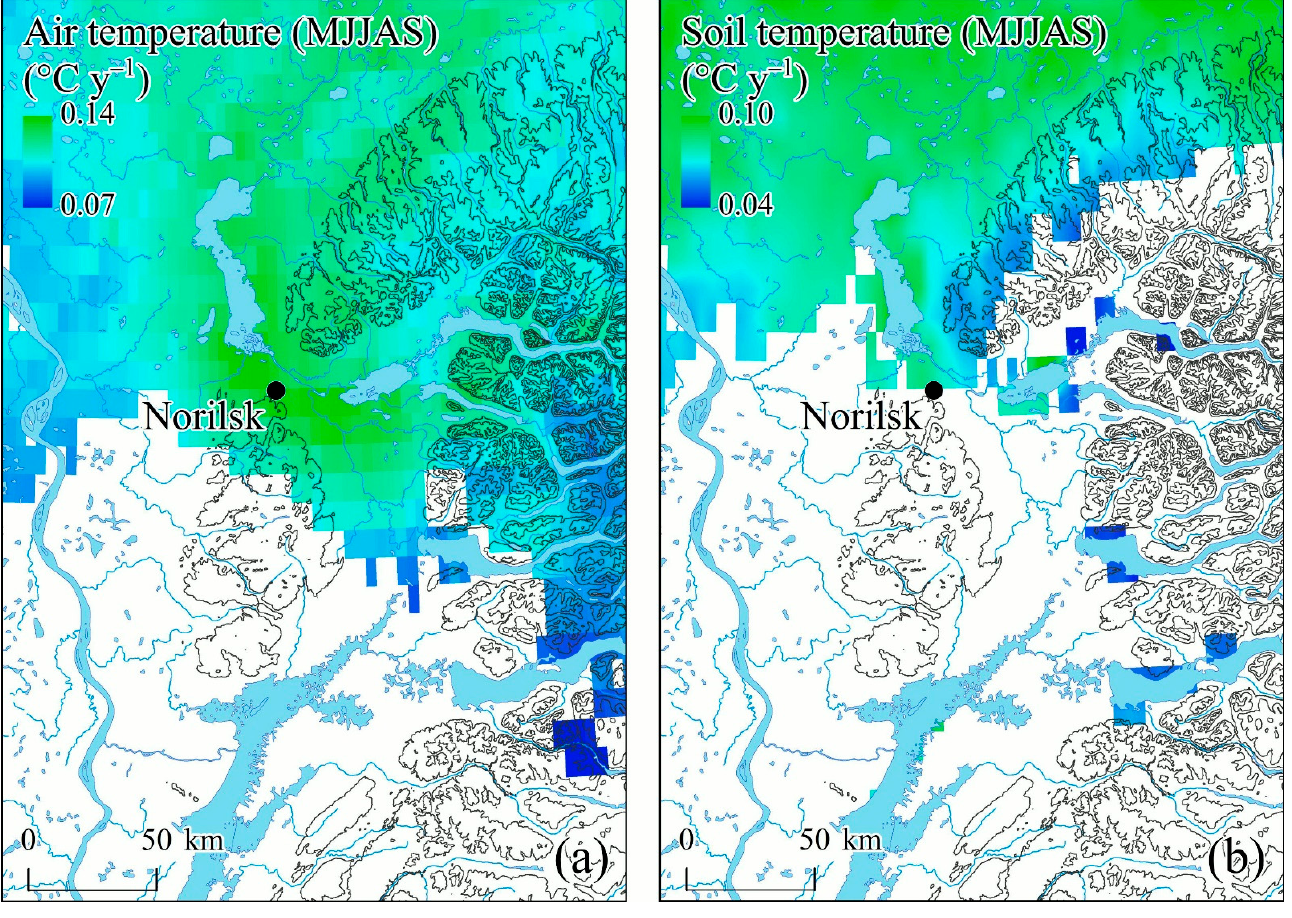
Figure 4. Maps of air ( a ) and soil ( b ) temperature trends (May–September; 2001–2021) ( p > 0.1). Water bodies are indicated by light blue. Black lines show the terrain’s elevation isolines.